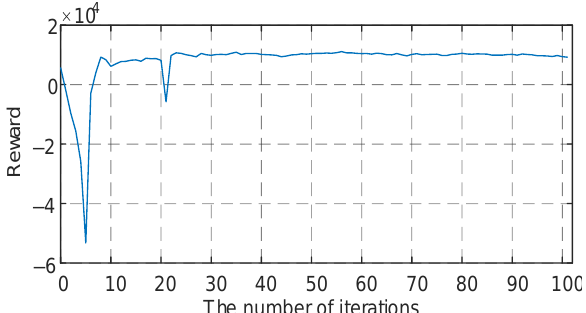
Figure 9. Cumulative rewards of each iteration.